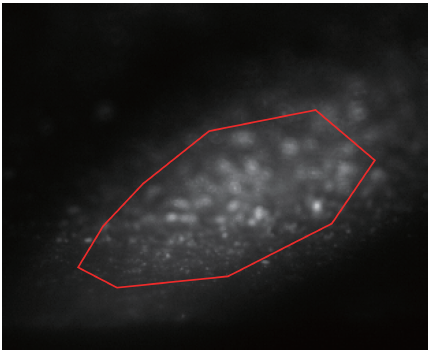
Figure 12. Example of an area of interest (AOI). The AOI is the area inside the red